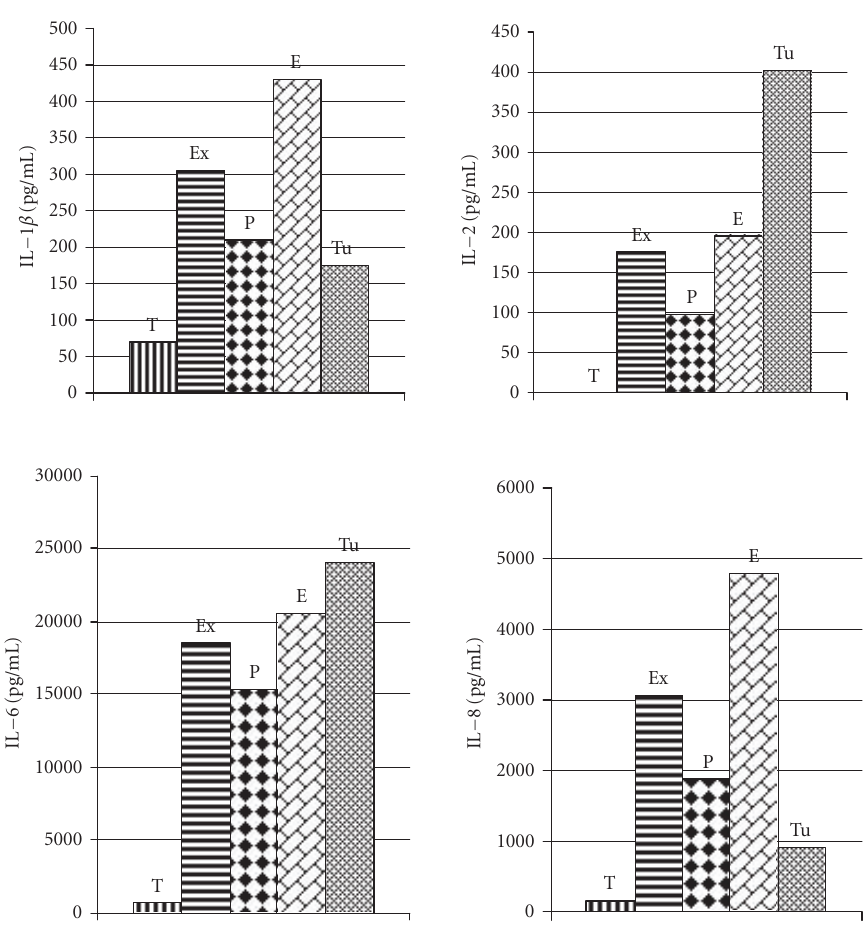
Figure 4. The levels of pleural fluids IL-1 β , IL-2, IL-6, and IL-8 in patients with di ff erent etiologic diagnosis in the exudate and transudate